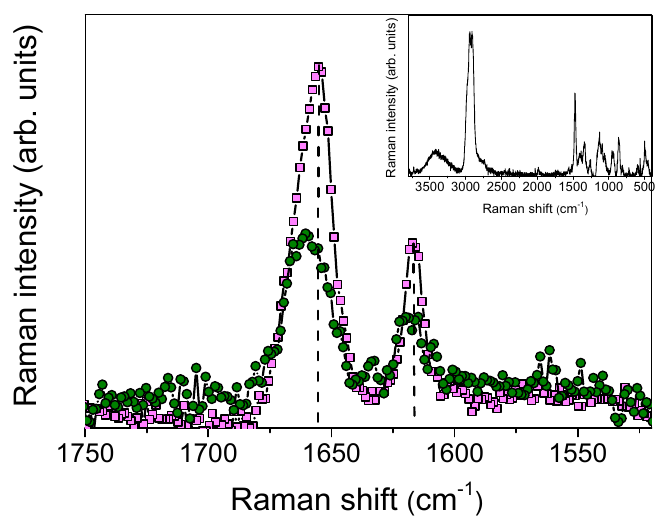
Figure 9. Raman spectra, in the 1750–1520 cm − 1 range, of IDE (pink squares) and IDE / HP- β -CD 1:2 inclusion complex (green circles). In the inset, the Raman spectrum of HP- β -CD in the 1750–1520 cm − 1 range is also reported.